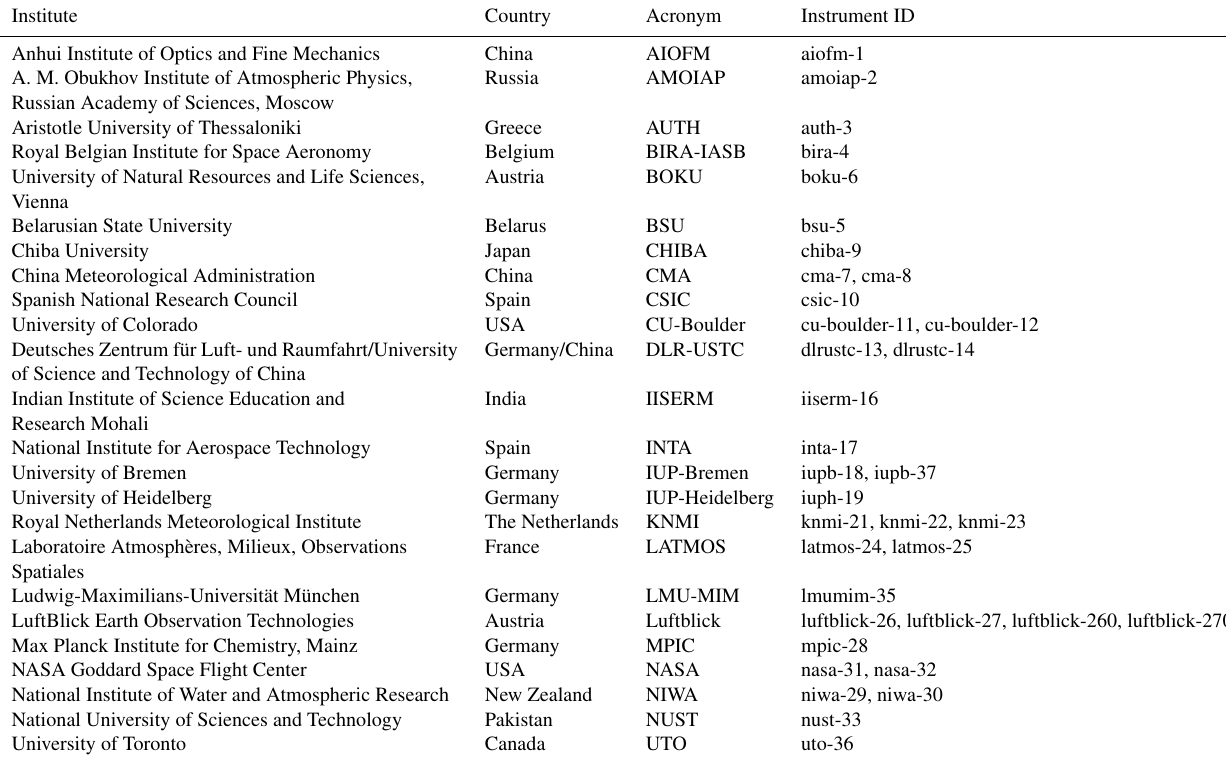
Table 1. List of participating groups and corresponding instrument IDs in alphabetical order according to their acronym.